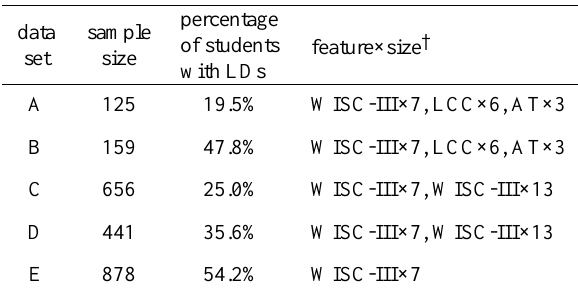
Table 1. Data sets and their features used in this